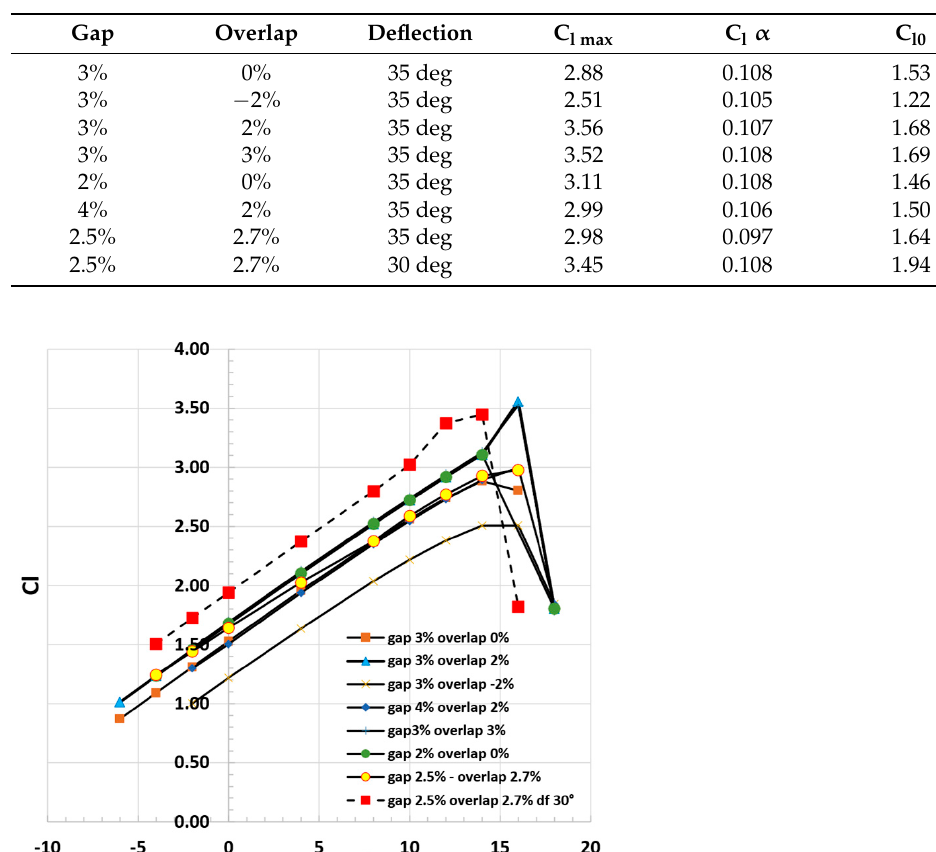
Table 10. Numerical results of 2D analysis at different flap positions, landing condition, M = 0.15, Re = 5.7 × 10 6 .